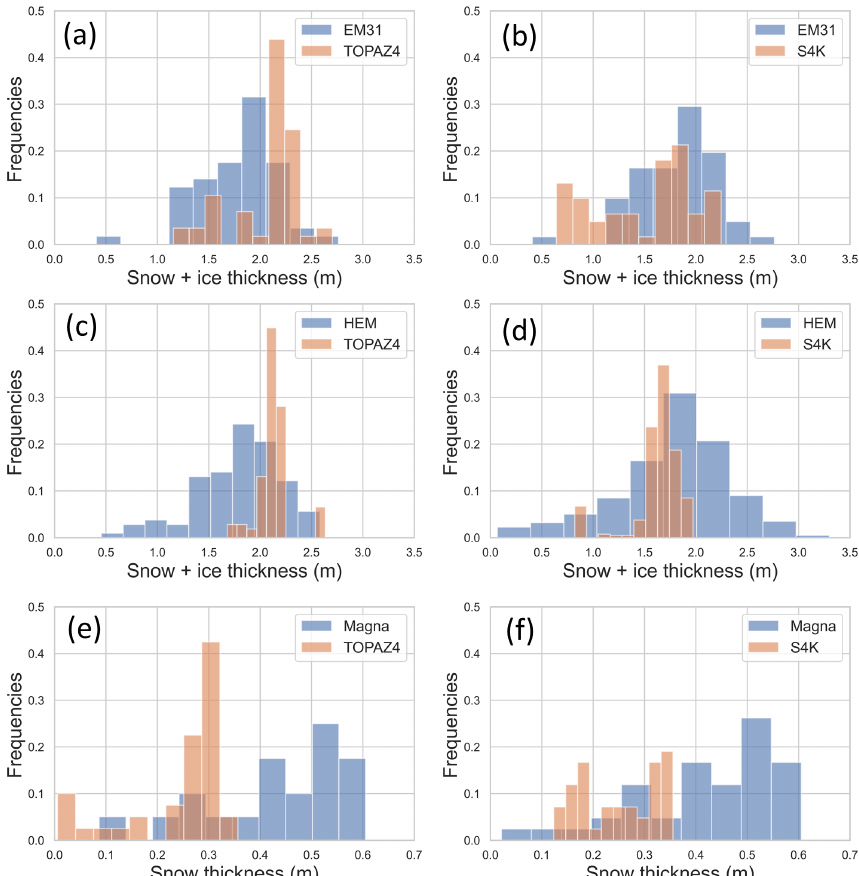
Figure 10. Observed (blue) and modeled (brown) frequency distributions of snow and ice thickness (a–d) and only snow thickness (e–f) . Measurements were taken during the N-ICE2015 expedition with the instruments indicated at the top of the panels: EM31 (a, b) and HEM (c, d) , for snow and ice thickness and Magnaprobe (e, f) for snow thickness. Observational data were averaged for TOPAZ4 (a, c, e) or S4K models cells located in the same areas, resulting in slightly different observed frequency distributions, given the different spatial resolution of the models (12.5 and 4km, respectively). Model results, averaged for the same areas and days where measurements took place: (a, c, e) from TOPAZ4 and (b, d, f) from S4K (refer to Table 5 and